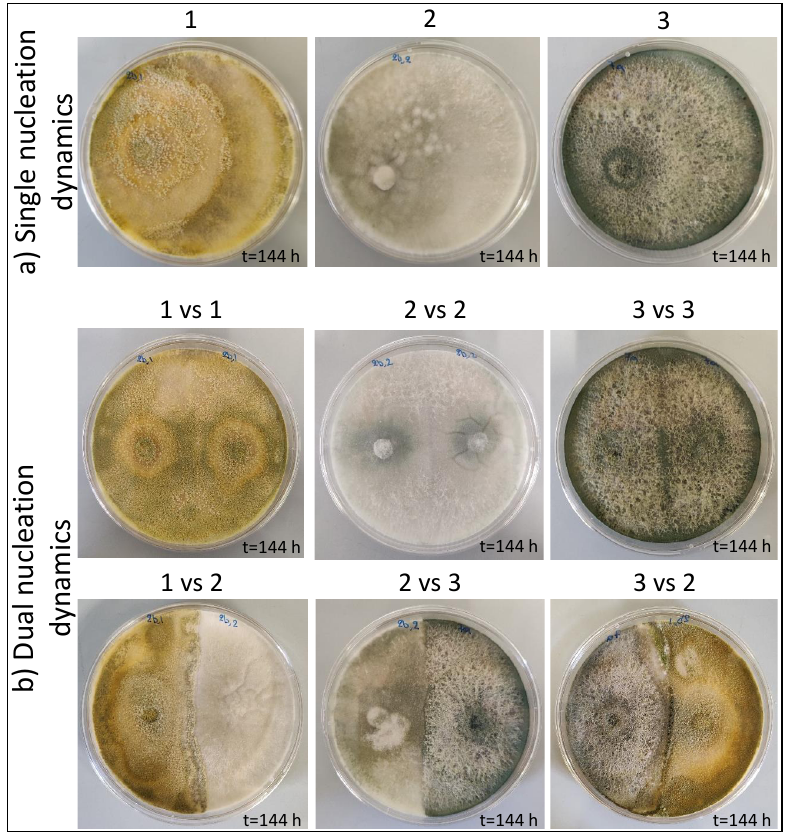
Figure 2. ( a ) Single nucleation dynamic and ( b ) Dual nucleation dynamic assay of Trichoderma strains. Fungal cultures were performed on a PDA medium as described in the Materials and Methods section. Pictures were taken up to 144 h post-cultivation. Fungal strains are as reported in Table 2, i.e., Trichoderma simmonsii EXF-17015 (No. 1), Trichoderma sp. EXF-17016 (No. 2), and Trichoderma